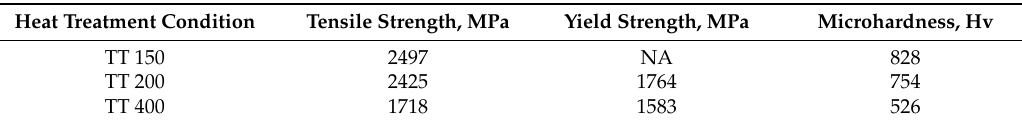
Table 1. Mechanical properties for three heat treatment